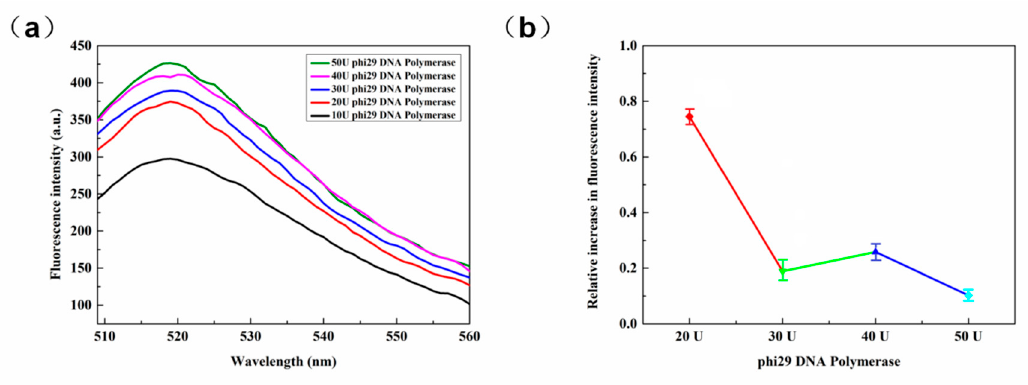
Figure 5. ( a ) Fluorescence spectra for various doses of phi29 DNA polymerase; ( b ) Fluorescence increase percentage comparison chart (521 nm).